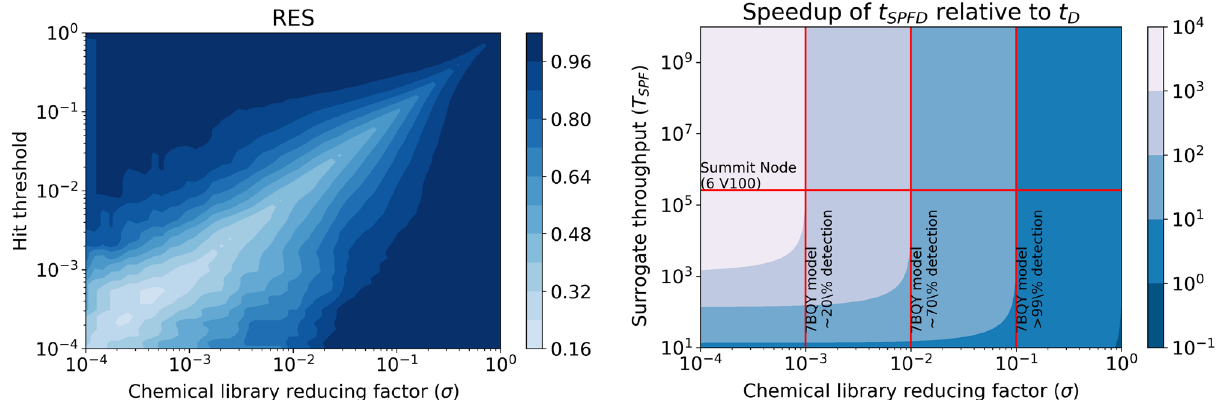
Figure 7. (left) Regression enrichment surface ( n = 200, 000 ) based on the surrogate model for 7BQY 65 . The x -axis represents σ which determines the level of filtering the model is used for (i.e., after predicting over the whole library, what percentage of compounds then used in the next stage docking). The y -axis is the threshold for determining if a compound is a hit or not. The point ( 10 − 1 , 10 − 3 ) is shaded with 100% detection. This implies the model over a test set can filter out 90% of compounds without ever missing a compound with a score in the 10 − 3 percentile. In concrete numbers, we can screen 200,000 compounds with the model, take the top 20,000 based on those inference scores, and dock them. The result is running only 20,000 docking calculations, but those would contain near 100% of the top 200 compounds (as if one docked the entire dataset). (right) Based current GPU, surrogate model, throughput is, T SPF , and the vertical lines correspond to the RES plot values